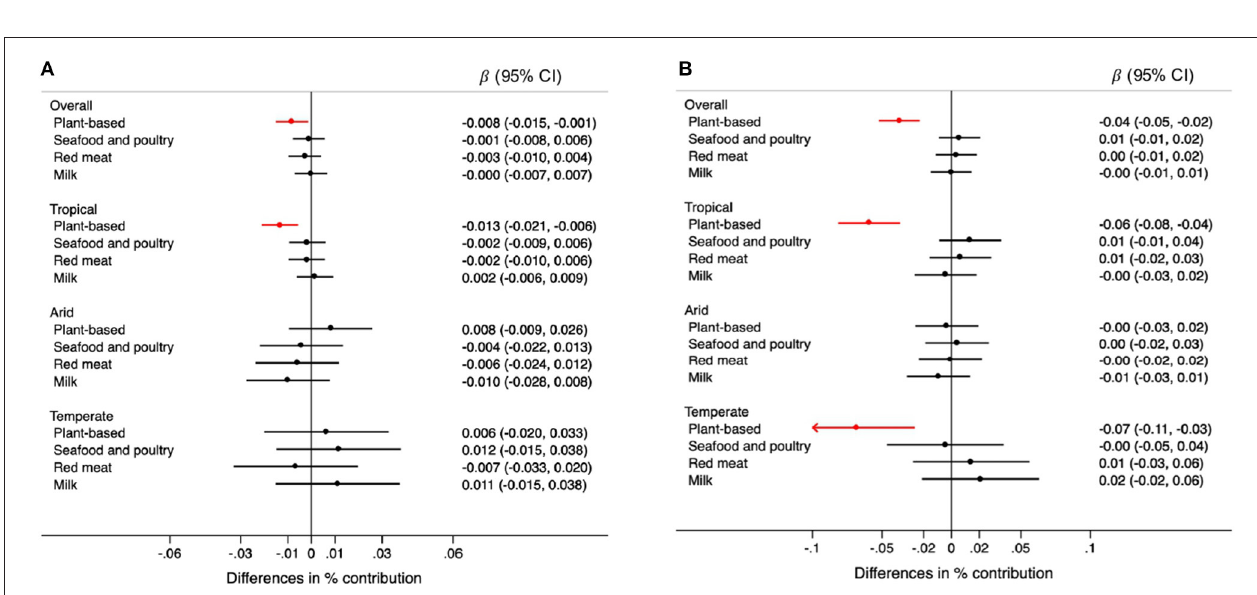
FIGURE 3 | Differences in the percentage (95% CIs) of contribution of type of unprocessed foods and beverages to the total energy intake for each 0.5mm annual decrease in rainfall (A) and for each 0.1 ◦ C annual increase in temperature (B) during the 5-year period prior to the survey, overall and by climate region. Values were obtained using multivariable multilevel linear regression models adjusted for climate region (overall models) sex, age group, educational level, and rainfall or temperature, as appropriate.